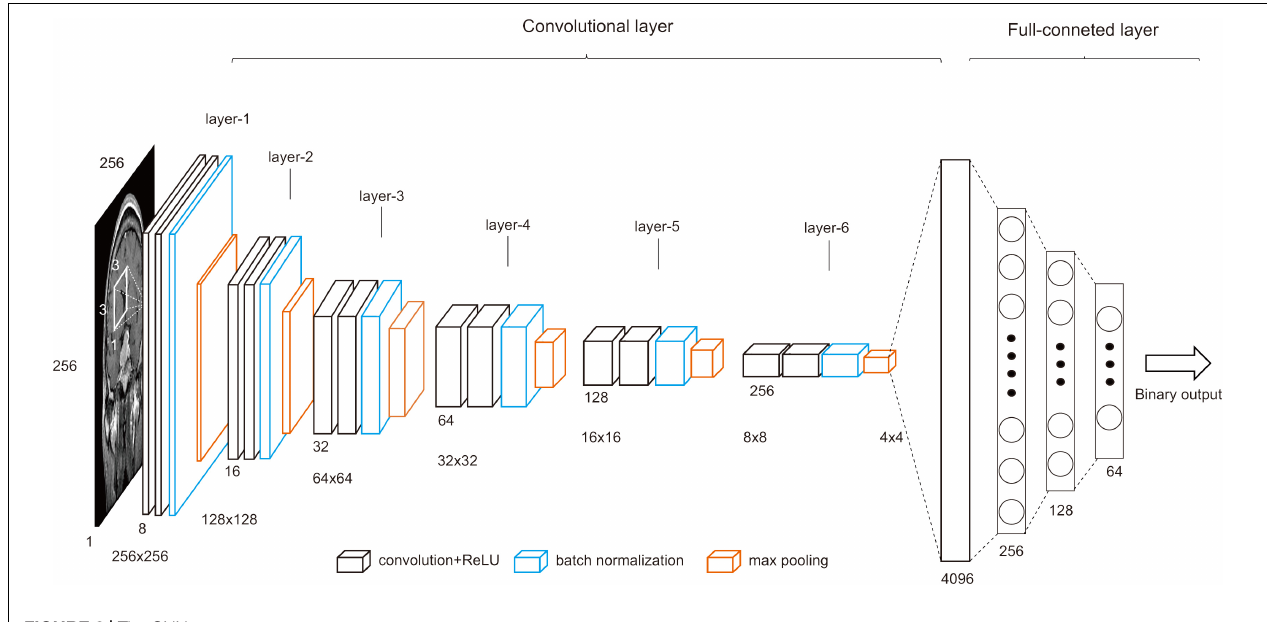
FIGURE 2 | The CNN structure.